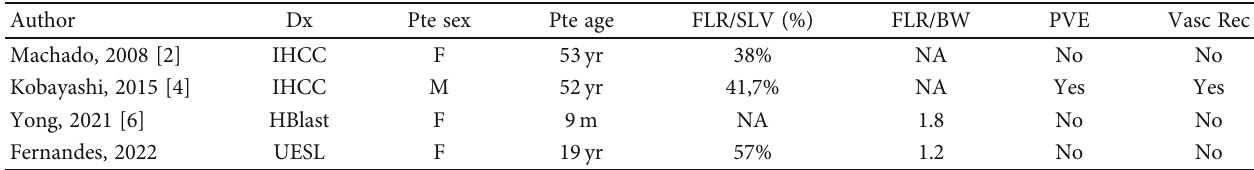
Table 1: Data from papers describing type 4 extended trisectionectomy (Dx: diagnostic; IHCC: intrahepatic cholangiocarcinoma; HBlast: hepatoblastoma; Pte: patient; yr: years; m: months; FLR: future liver remnant; SLV: standard liver volume; BW: body weight; NA: not available; PVE: portal vein embolization; Vasc Rec: vascular